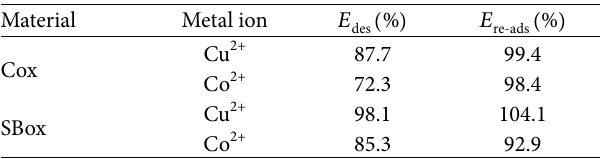
Table 4: Desorption efficiency for Cu 2+ and Co 2+ for Cox and SBox re-ads (𝐸 )